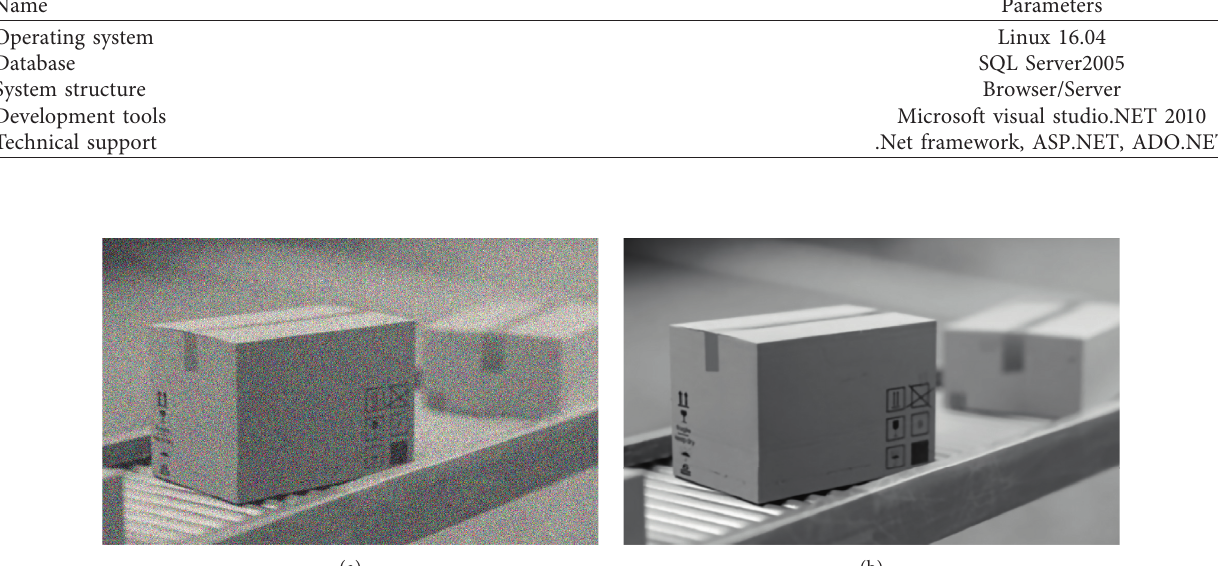
Figure 13: Processing results by using the median filtering optimization algorithm (a) original image; (b) the image after median